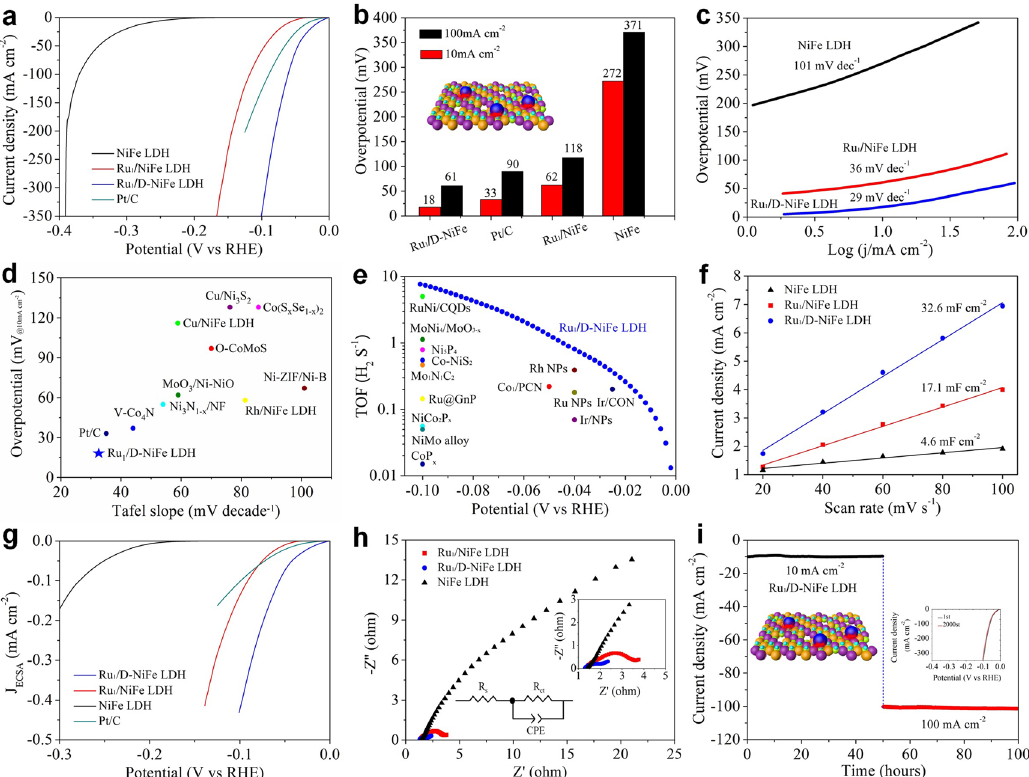
Fig. 3 HER catalytic performance. a HER polarization curves, b overpotentials at typical current densities, c Tafel slopes of various LDHs, d comparison of merit with respect to both kinetics (Tafel slope) and activity (the overpotential at 10 mA cm − 2 ), e TOF values of Ru 1 /D-NiFe LDH (blue dots), together with reported HER electrocatalysts at typical overpotentials, f double-layer capacitances ( C dl ), g polarization curves with the current normalized to ECSA of NiFe LDH, Ru 1 /NiFe LDH, and Ru 1 /D-NiFe LDH, h electrochemical impedance spectroscopy, i time-dependent current density curves of Ru 1 /D-NiFe LDH at − 0.018 and − 0.061 V vs. RHE. Inset is LSV curves before and after 2000